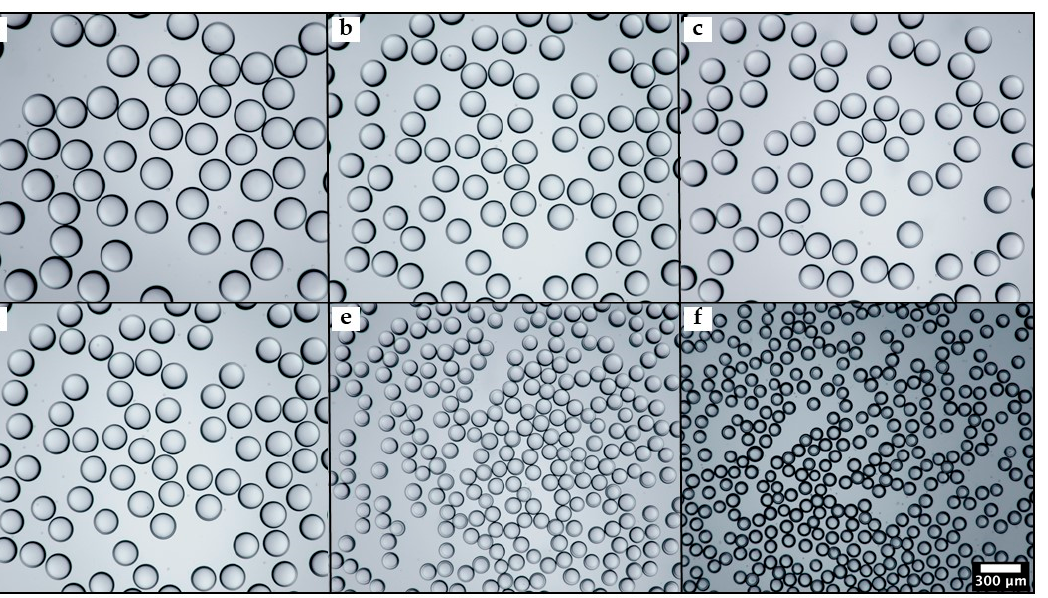
Figure 5. Optical microscopy images of PEGDA particles produced using inner capillary with different orifice diameters: ( a ) 400 μ m; ( b ) 350 μ m; ( c ) 300 μ m; ( d ) 250 μ m; ( e ) 200 μ m; and ( f ) 150 μ m. The average particle diameters are 239 μ m, 194 μ m, 191 μ m, 145 μ m, 122 μ m, and 107 μ m, respectively. The same scale bar applies to all images.